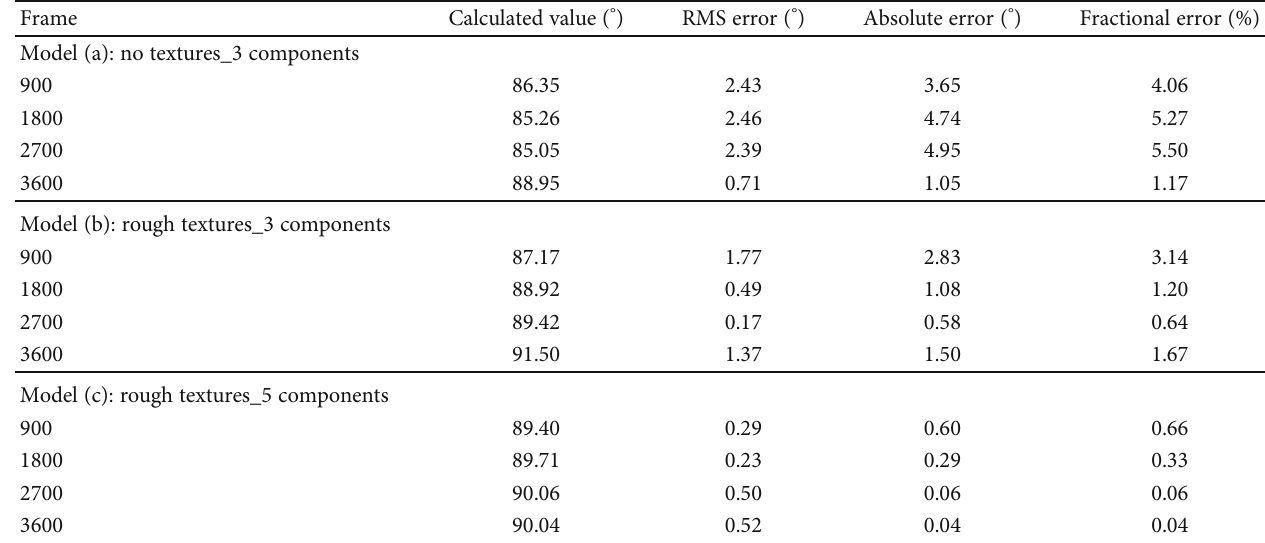
Table 2: Calculated values and the errors of three di ff erent models under di ff erent imaging speeds (rotation angle of 90 degrees).